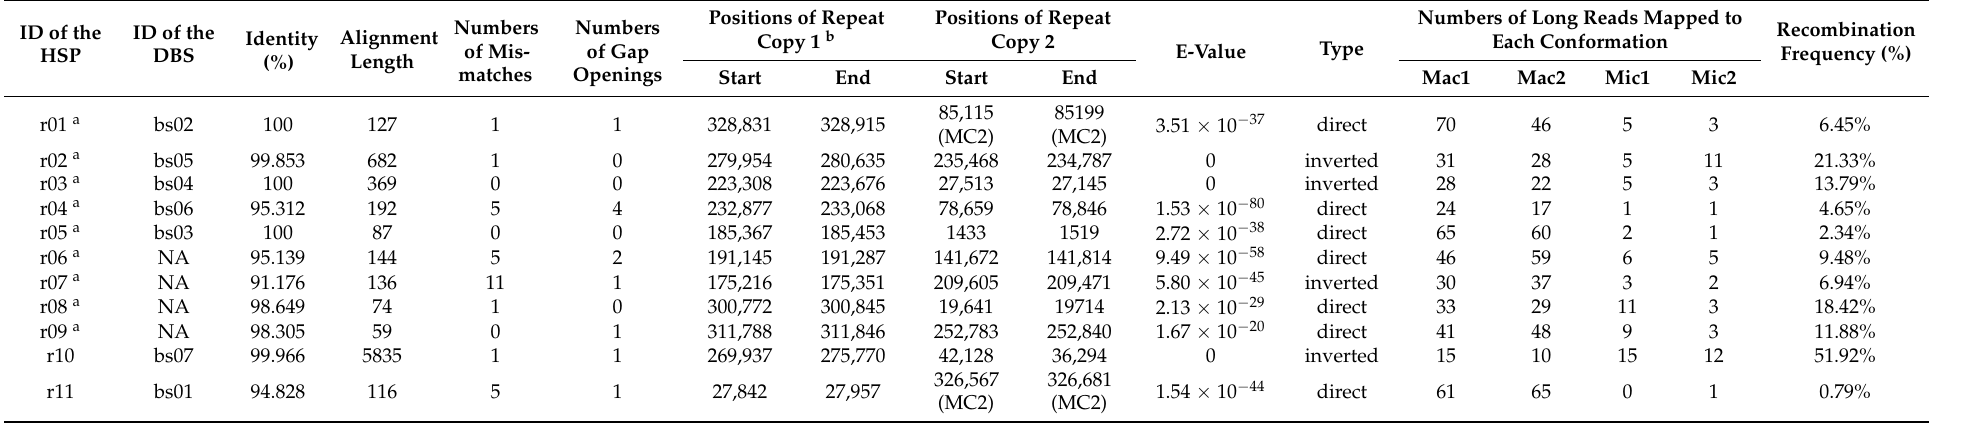
Table 1. Results for mapping PacBio long reads to the four possible conformations associated with eleven HSPs (r01–r11) and their corresponding seven DBSs (bs01–bs07). “MC1/2”: mitogenome chromosome 1/2. a : Validated successfully with PCR; b : all positions are based on MC1, except those marked with MC2.